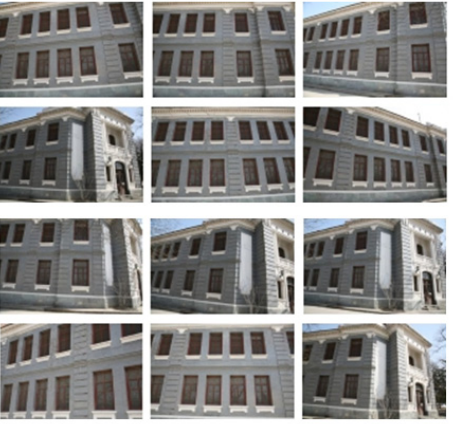
Figure 8 . The thumbnail of multiview images.